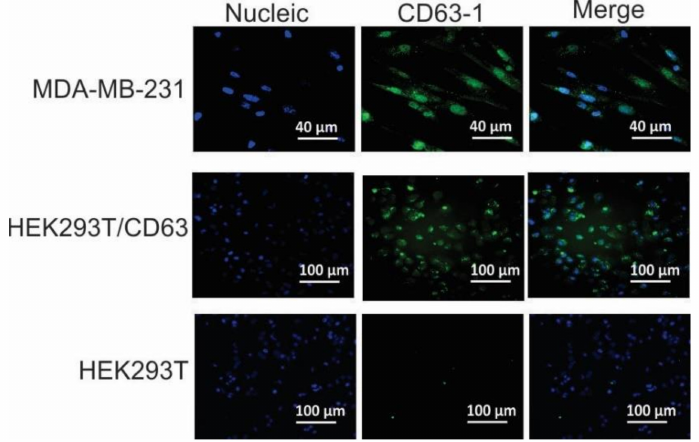
Figure 4. Specific binding of CD63-1 aptamer to CD63-positive cells. After incubating with 200 nM of aptamers for 30 min at 37 ◦ C, cells were imaged using confocal microscopy. Green denotes aptamer (FAM), and blue denotes nuclei (Hoechst 33342). Before performing the test, cells were incubated with excessive (10 µ g / 500 µ L / test) salmon sperm DNA to block the potential binding motif of